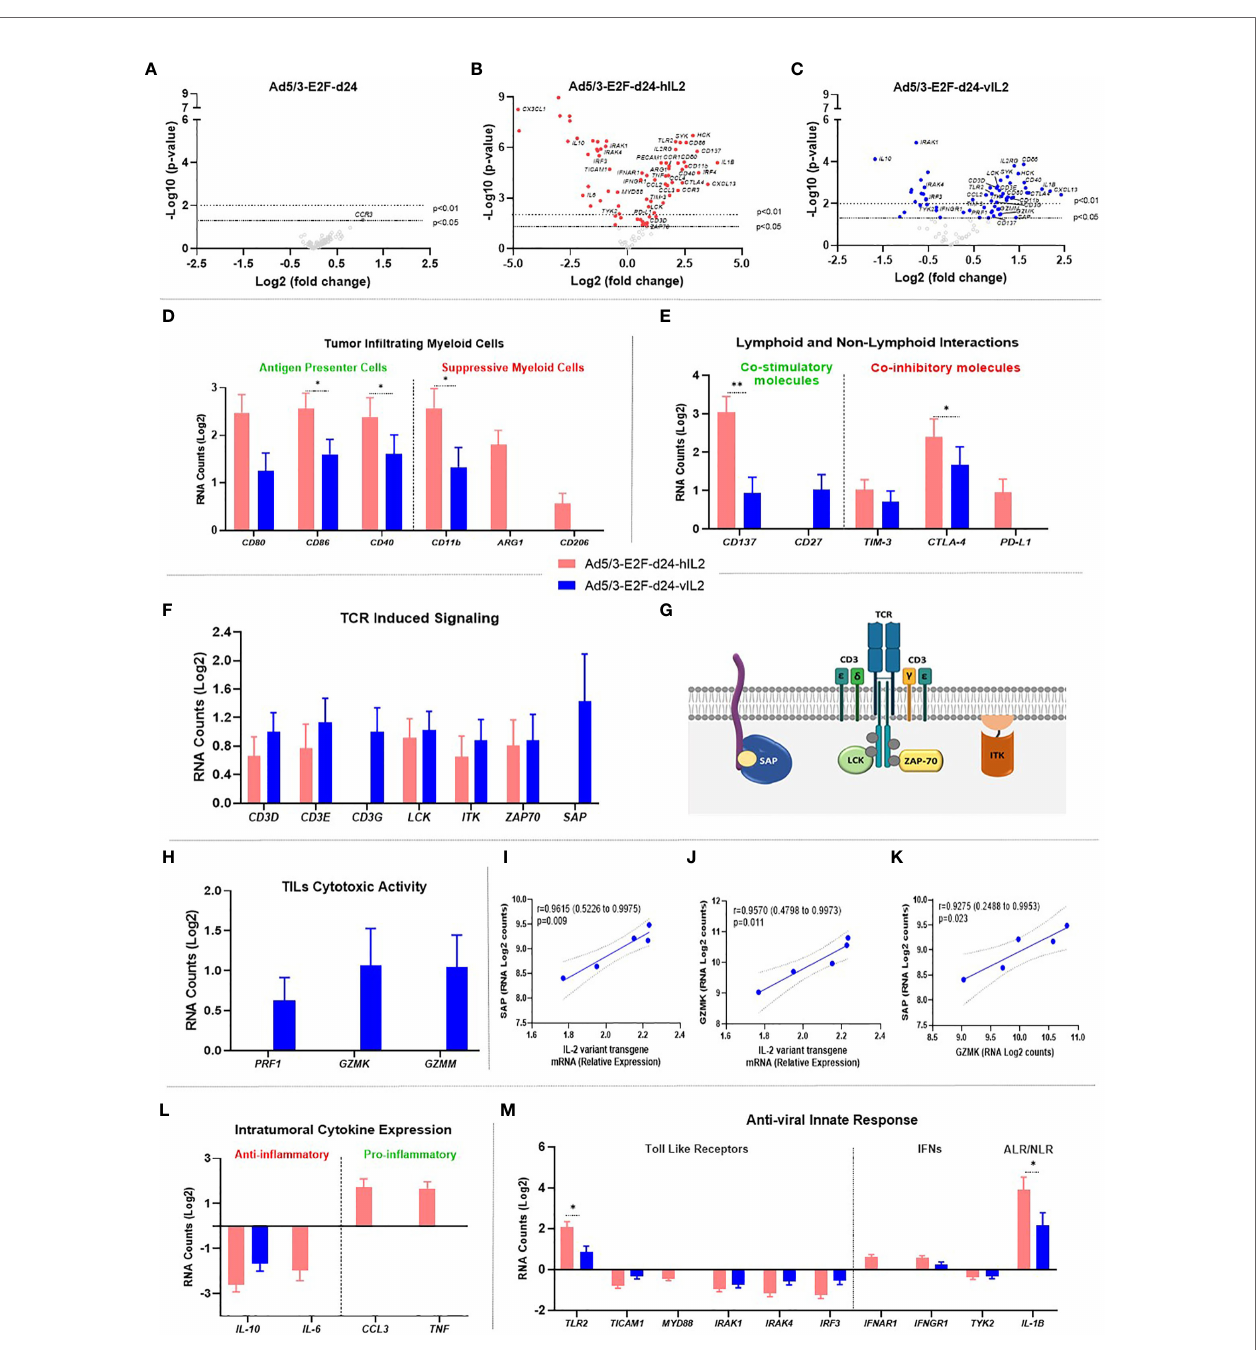
FIGURE 5 | Molecular gene expression analysis in the virus treated tumors. (A – C) Volcano plot graphs showing each gene ’ s -log10(p-value) and log2 fold change with expression change upon (A) Ad5/3-E2F-d24, (B) Ad5/3-E2F-d24-hIL2, and (C) Ad5/3-E2F-d24-vIL2 treatments. Statistically signi fi cant genes fall at the top of the plot above the horizontal lines, and differentially expressed genes fall to left and right sides on the X axis. The dashed horizontal lines represent the signi fi cance levels thresholds: p<0.05 or p<0.01. (D) Log2 mRNA expression of genes associated to antigen presenting cells (left side) and to suppressive myeloid cells (right side). (E) Lymphoid and non-lymphoid interactions: mRNA (Log2) expression study on co-stimulatory (left side) and co-inhibitory molecules (right side). (F) Log2 mRNA expression of genes associated to TCR induced signaling. (G) Graphical illustration of TCR signaling involved proteins on the surface of lymphocyte cells. (H) Log2 mRNA expression of TIL cytotoxicity genes. (I) Correlation between SAP and vIL-2 transgene expression levels. (J) Correlation between GZMK and vIL-2 transgene levels. (K) Correlation between SAP and GZMK expression levels. (L) Intratumoral expression of anti-in fl ammatory cytokines (left side) and pro- in fl ammatory cytokines (right side) as mRNA (Log2) levels. (M) Anti-viral innate immune response related to TLRs (left side), IFNs (middle), and in fl ammasome signaling via AIM2-like receptors (ALRs) and NOD-like receptors (NLRs) (right side) as mRNA (Log2) expression. All data is presented as mean + SEM. *p < 0.05, **p <